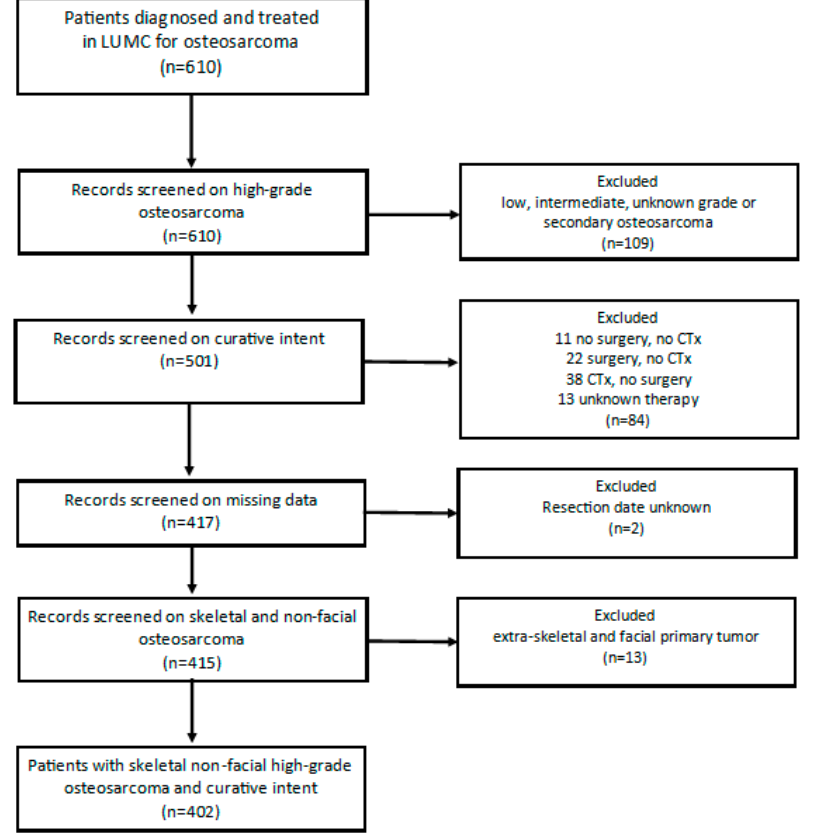
Figure 1. Flowchart patient selection. Legend; LUMC = Leiden University Medical Center, CTx = Chemotherapy.